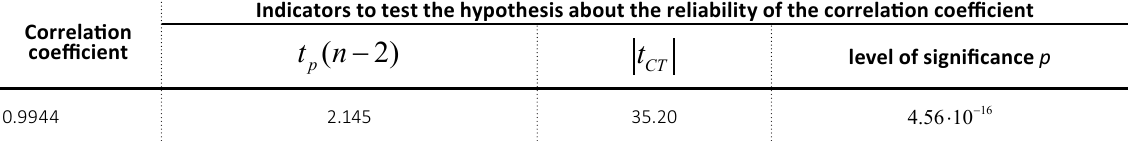
Source: Calculated by the authors.